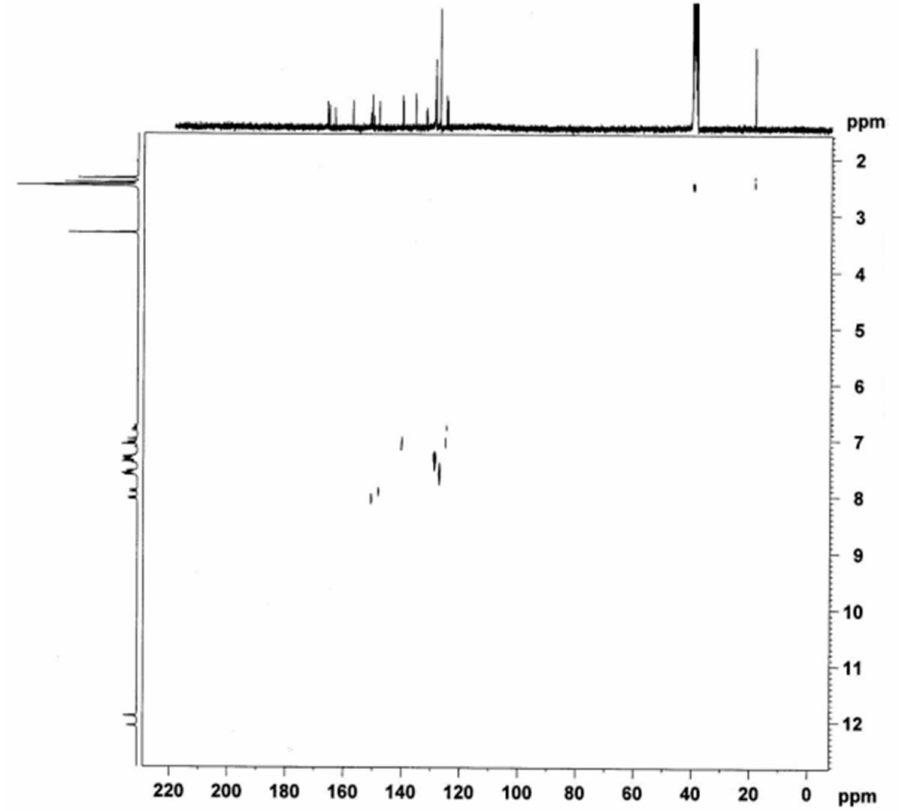
Figure 1. The correlation spectrum of proton and carbon of the most active compound 3 from this